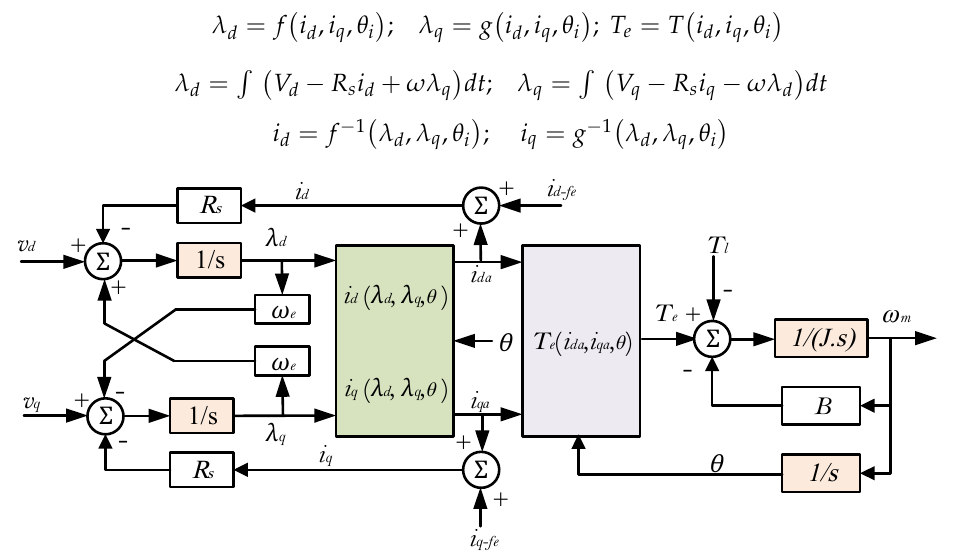
Figure 2. The schematic of the proposed IPMSM machine model.